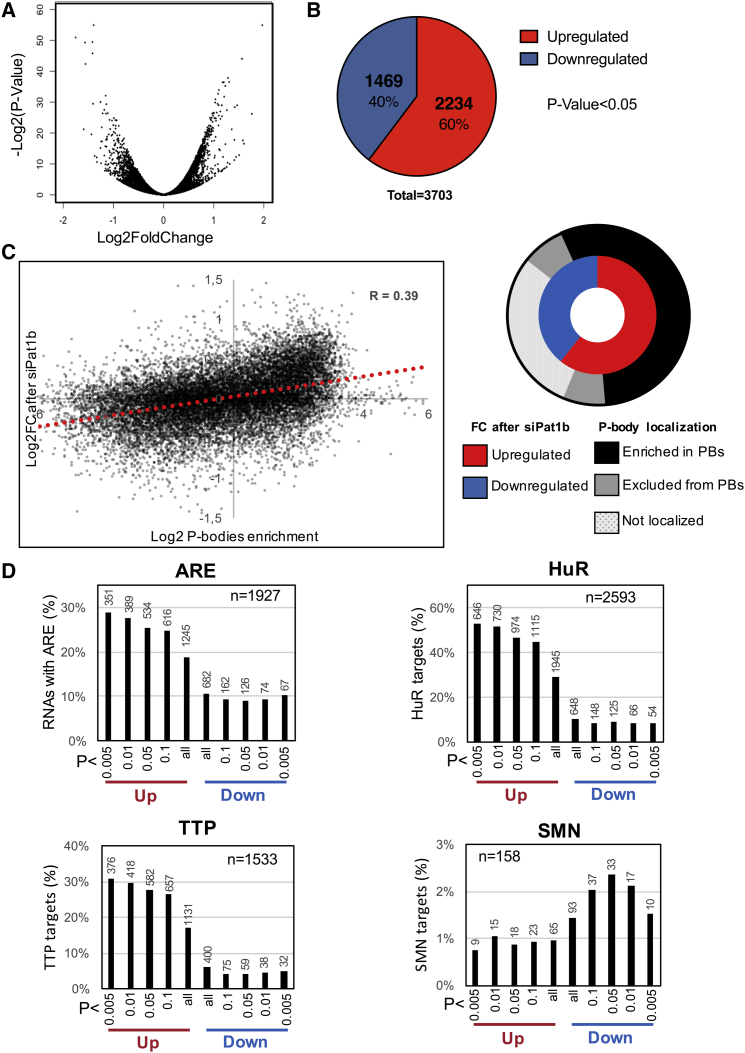
RNA-Seq Analysis of Transcriptome Changes following Pat1b Knockdown in HEK293 Cells(A) Volcano plot representing log2 fold changes in RNA expression and their associated p values. Differential gene expression was analyzed using DESeq2.(B) Pie chart showing the number of high-confidence (p value < 0.05) upregulated (in red, fold change > 0) or downregulated (in blue, fold change < 0) transcripts after Pat1b depletion.(C) Positive correlation between upregulation after Pat1b depletion and enrichment in P bodies. The dot plot represents the 16,451 RNAs common to both analyses, while the pie chart shows the strong overlap between transcripts significantly upregulated after Pat1b depletion (in red) and significantly enriched in P bodies (in black).(D) Enrichment of AU-rich element (ARE) mRNAs and targets of TTP and HuR in upregulated RNAs, and enrichment of SMN targets in downregulated RNAs. For each panel, the bars represent the percentage of transcripts of interest in the RNAs that are up- or downregulated after Pat1b depletion, while the tag above the bars is their absolute number. The total number of RNA targets in the Pat1b dataset is indicated. The enrichment is stronger for highly confident fold changes.See also Figure S7.